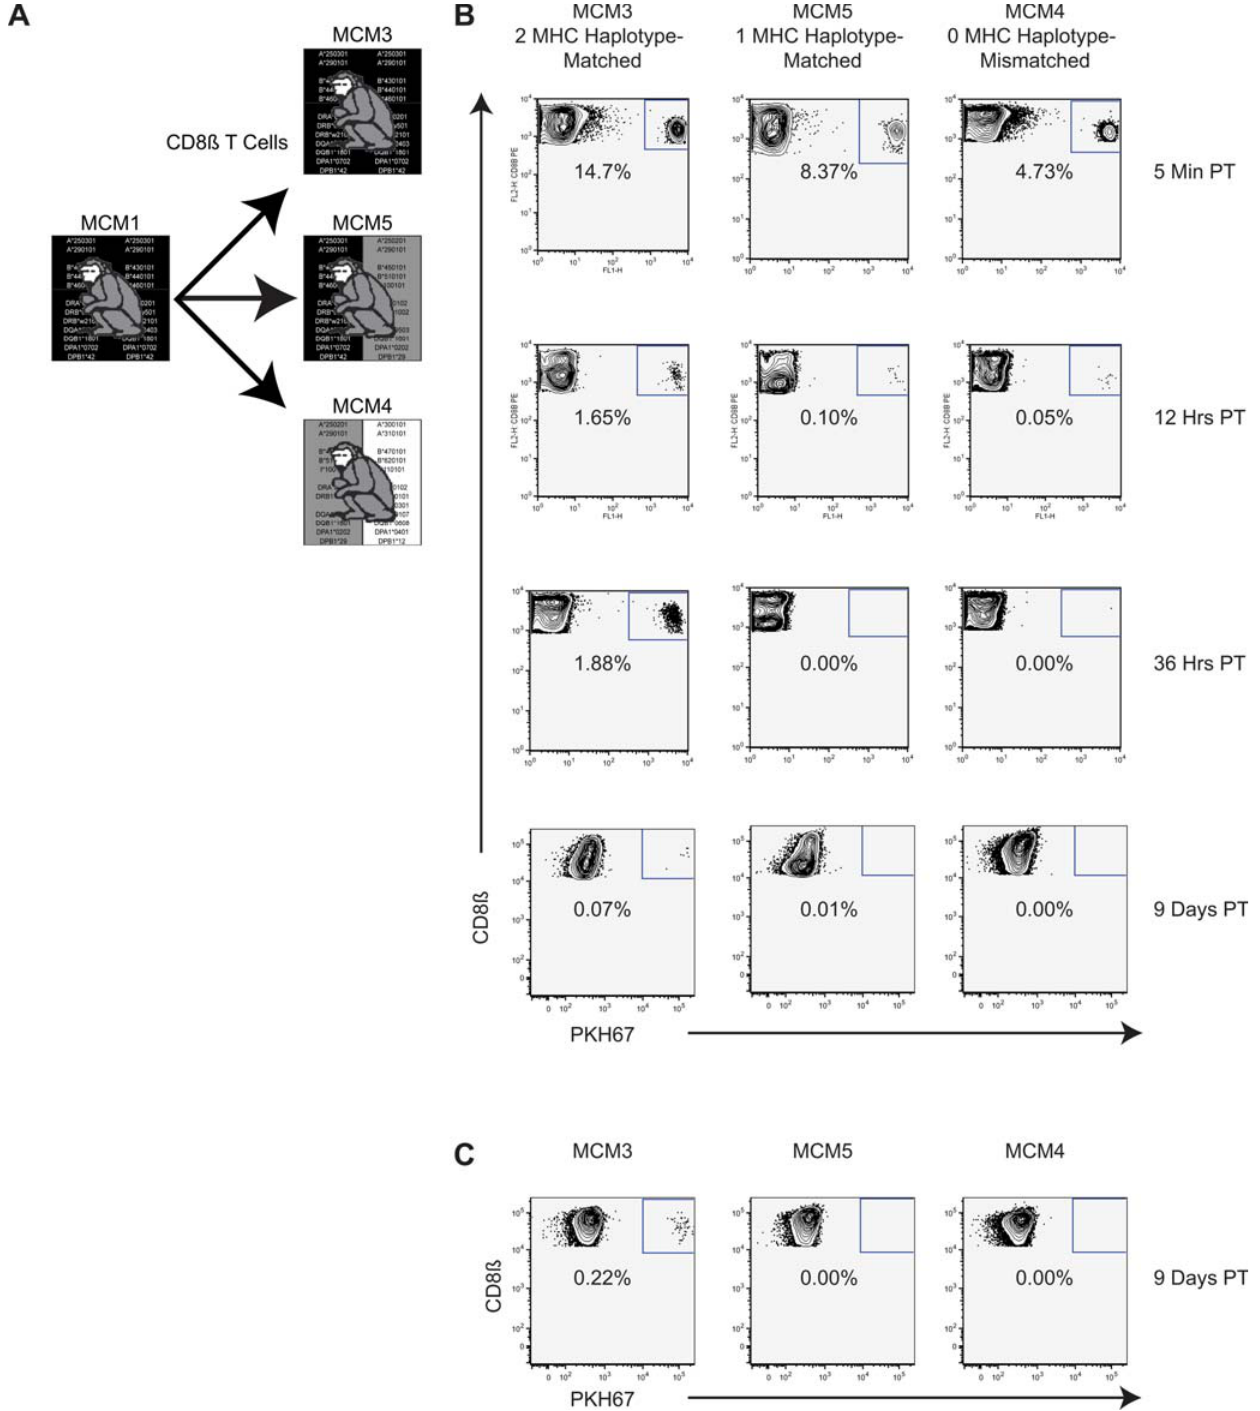
Figure 4. Allogeneic adoptive transfer from MCM1 to MCM3, MCM4, and MCM5 . Gating strategy is described in the legend to Figure 2. A Diagram displaying the transfer protocol. B Donor CD8ß + cells were transferred from MCM1 into 2-MHC-haplotype-matched MCM3, 0-MHC- haplotype-matched MCM4, and 1-MHC-haplotype-matched MCM5 and monitored for persistence in recipient PBMC. 220 million CD8ß + were transferred to each animal. Donor cells were a composite of CD8ß + cells enriched from PBMC, mesenteric lymph node and spleen. C Left inguinal lymph node sample 9 days post-transfer.